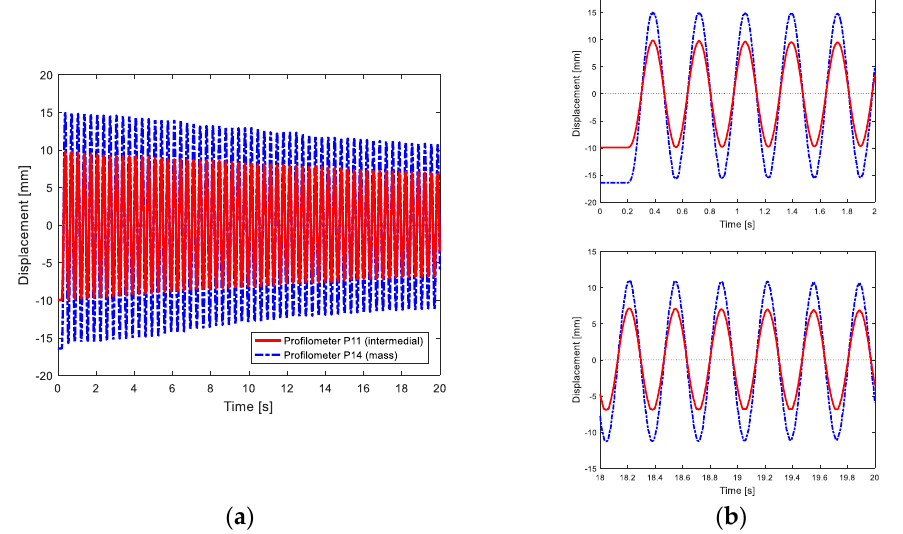
Figure 7. Time history of BD test using profilometer ( a ), with details at 0–2 s and 18–20 s ( b ); red line identifies the detected intermedial point, blue line the point detected at the mass.